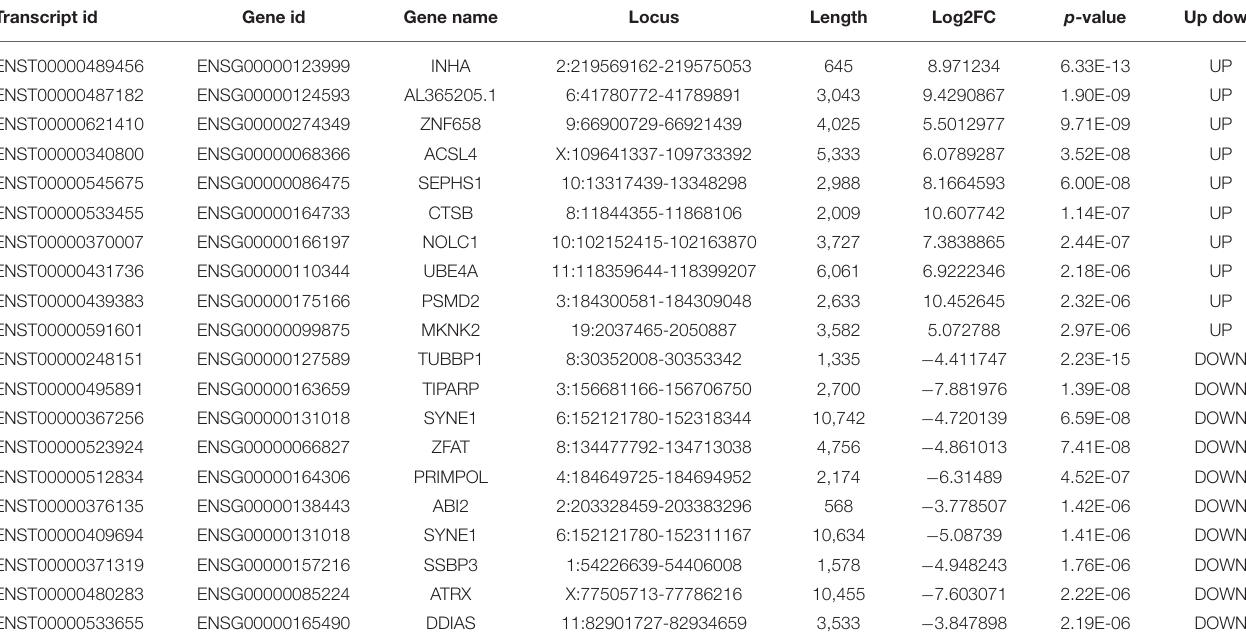
TABLE 5 | The ten most upregulated and ten most downregulated